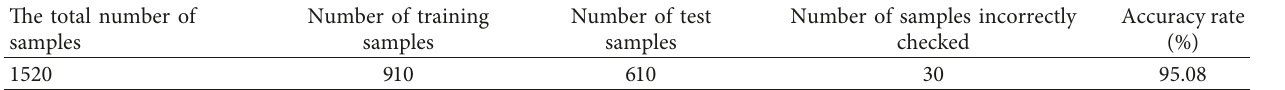
Table 1: Naive Bayes classifier test.